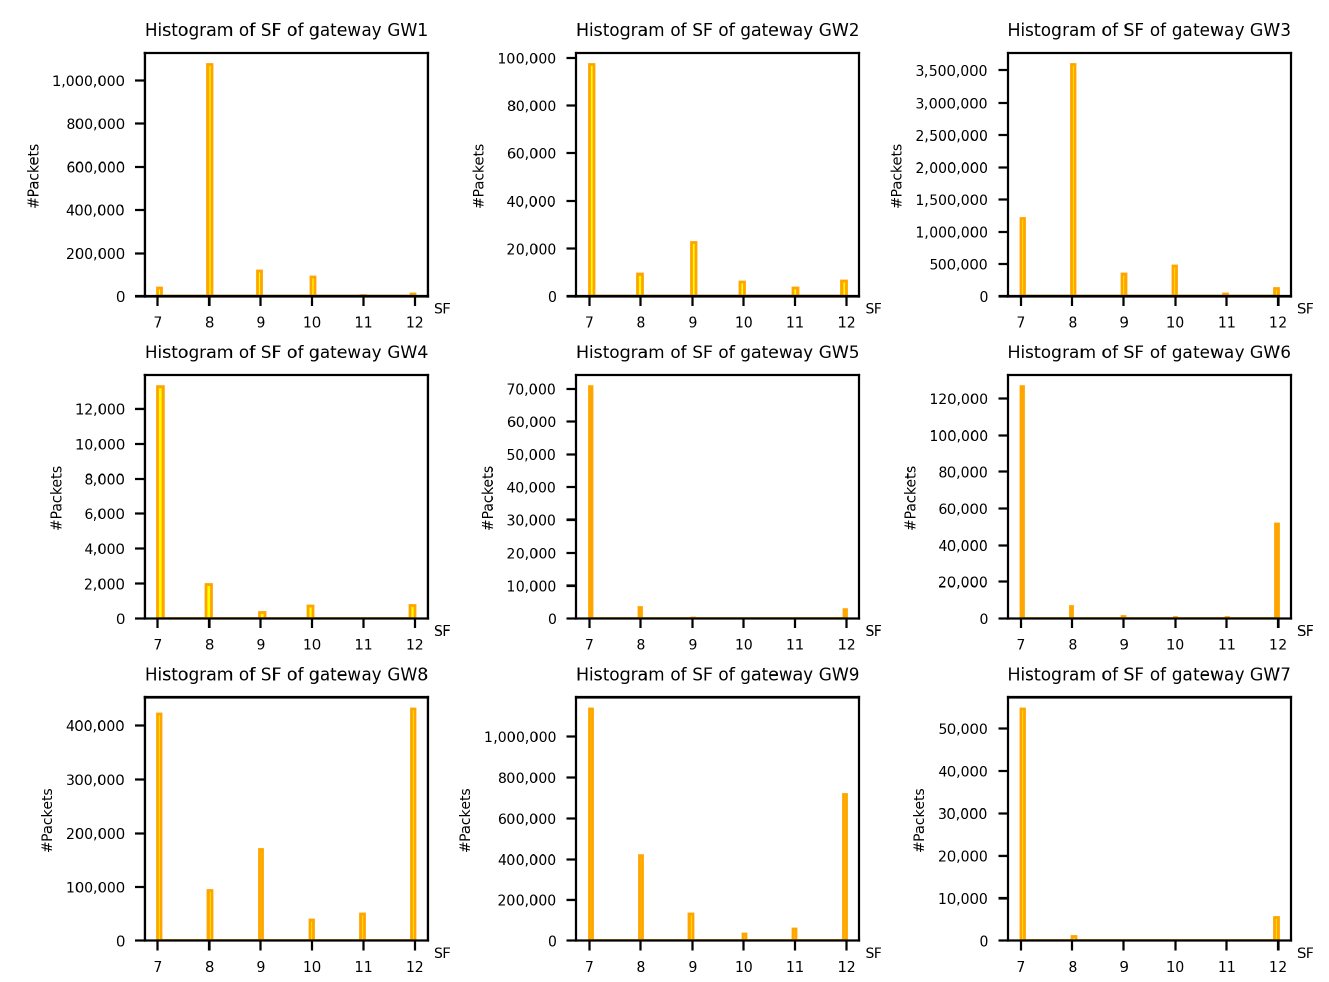
Figure 7. Histogram of spreading factor per